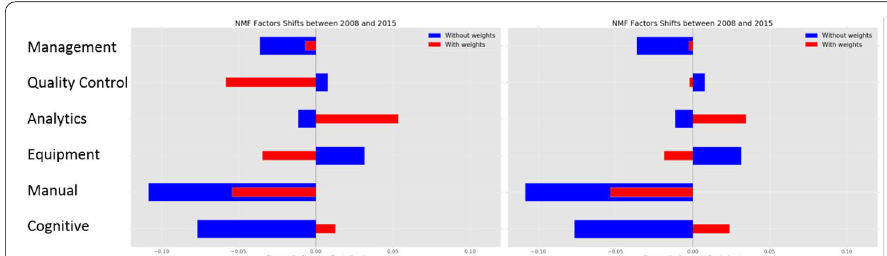
Fig. 12 NMF GCC oil& gas courses LSI (left) and LDA (right)